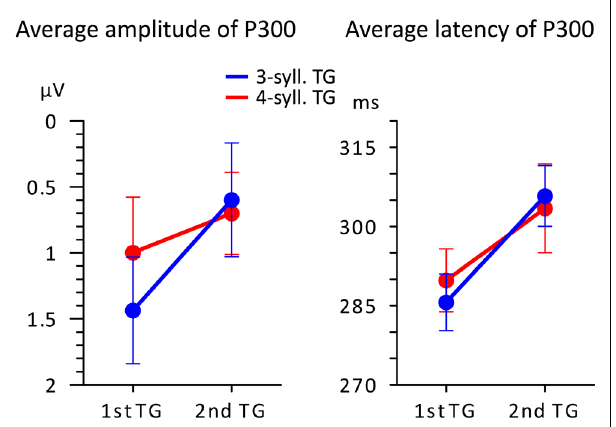
FIGURE 4 |Average amplitude and latency ( n = 16) of the P300 peak plotted according toTG position (first vs. second) andTG length (blue = 3-syll. vs. red = 4-syll.). Vertical bars represent standard